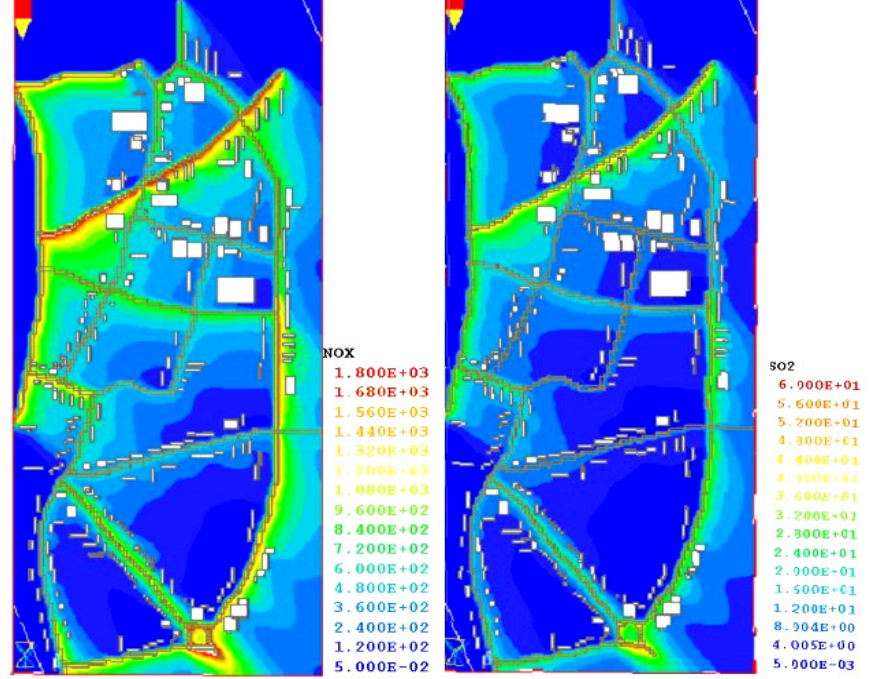
Fig. 5. Modelling results of scatter of CO concentration 3 ( µ g/m ) in Žirmūnai when wind blows from the north west at 3 m/s speed